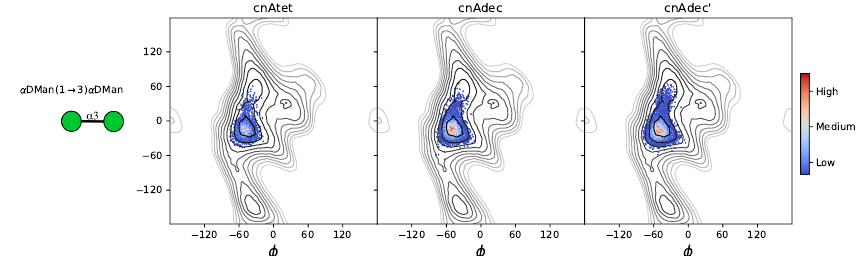
Figure A2. Heat maps of the distribution of the central backbone α DMan(1 → 3) α DMan glycosidic linkage orientation for a the cnAtet tetrasaccharide fragment ( left ) and decasaccharide cnAdec ( middle ) as well as a 6-O-acetylated decasaccharide cnAdec’ ( right ). Glycosidic linkage orientations are shown as rotations of the linkage dihedral angles φ and ψ .